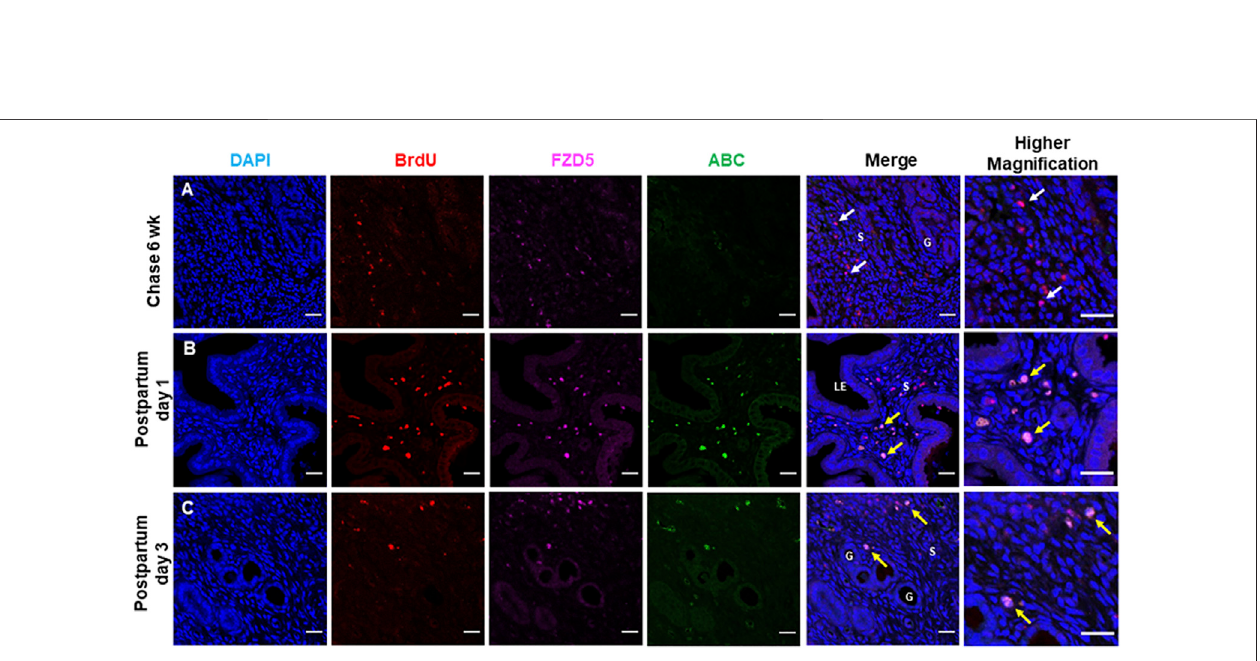
Frontiers in Cell and Developmental Biology |